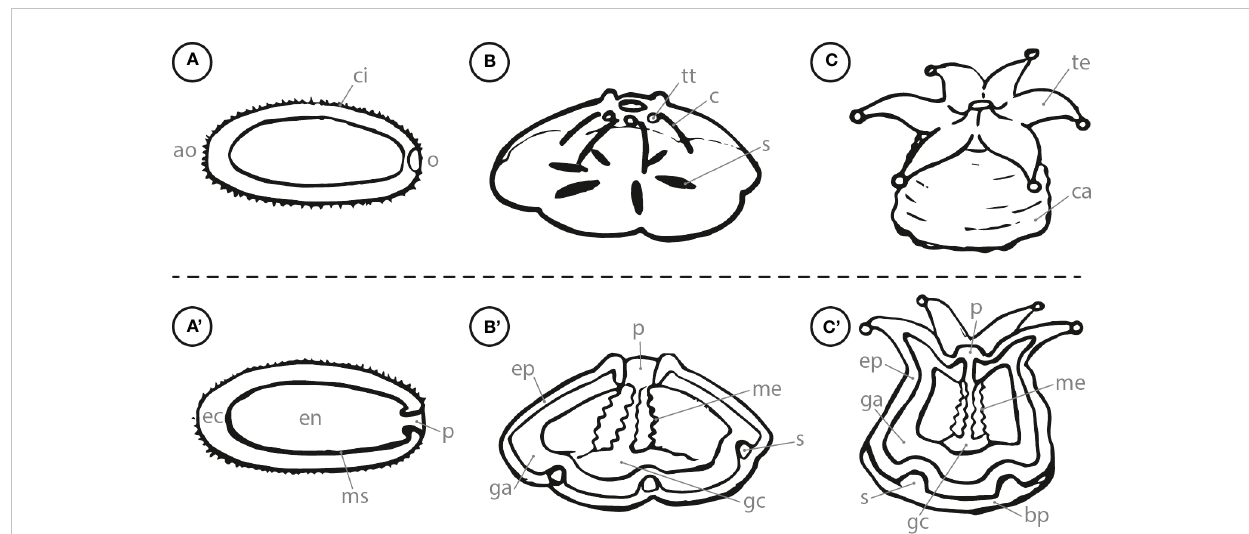
FIGURE 1 Side view (letter) and cross section (letter with apostrophe) of (A) swimming planula coral larva; (B) attached, metamorphosing larva; (C) coral recruit. ao, aboral; o, oral; ci, cilia; ec, ectoderm; en, endoderm; ms, mesogleal layer; p, pharynx; tt, tentacle tip; c, constriction; ep, epiderm; ga, gastroderm; me, mesenteries; s, septa; gc, gastrovascular cavity; te, tentacle; ca, calyx; bp, basal